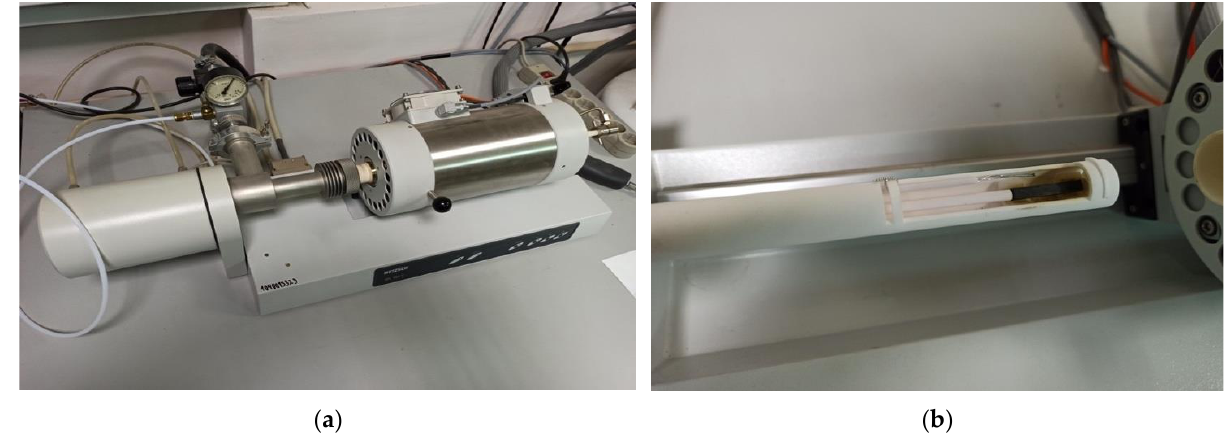
Figure 1. Dilatometer Netzsch DIL 402 C ( а ) in process; ( b ) with sample